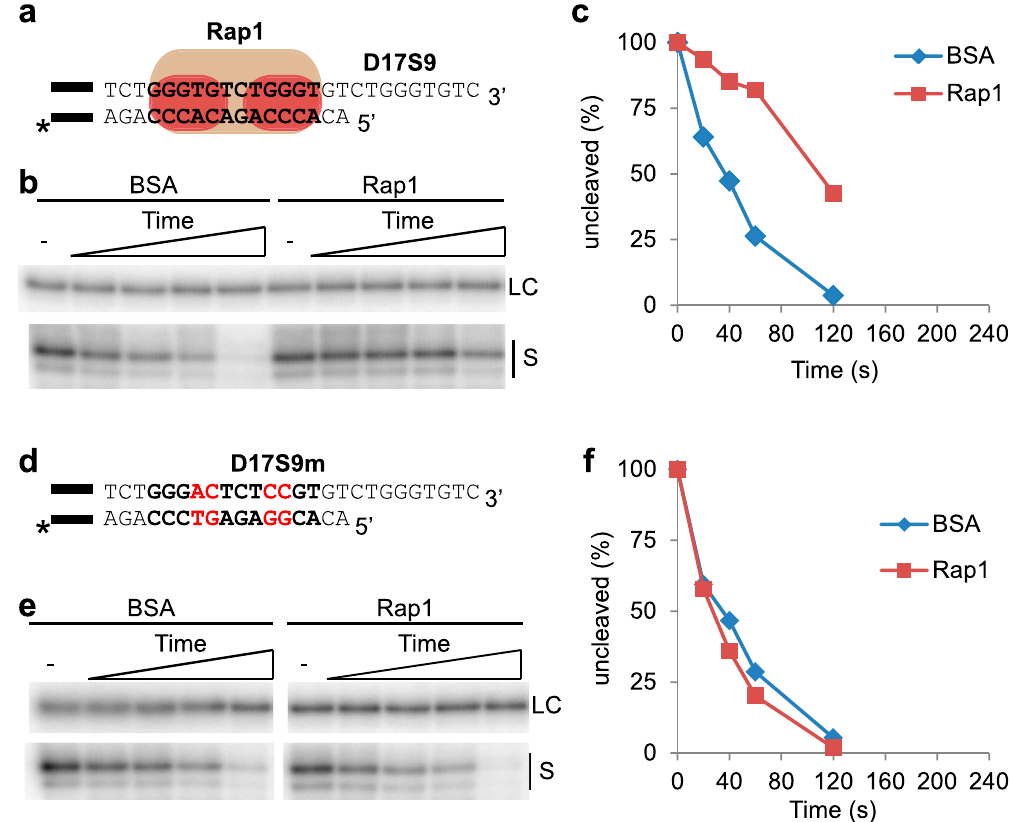
Figure 4. Rap1 protects the 5 ′ end when bound to dsDNA 2 nt inwards of the ds-ss junction. ( a,d ) The substrates used for DEPA experiments. The black bar indicates the guide sequence, and “ * ” the radioactive label (as described in Fig. 2 legend). ( a ) The telomere substrate D17S9 contains 17 bp dsDNA and a 9 nt 3 ′ overhang. The Rap1 MBS (bold text) is located 2 nt inwards of the ds-ss junction. ( d ) Substrate D17S9m contains 17 bp telomere dsDNA with four mutations in the Rap1 MBS (bold letters, mutations in red) and a 9 nt ssDNA 3 ′ overhang. ( b,e ) DEPA sequencing gels of D17S9 ( b ) and D17S9m ( e ), showing the loading control (LC) and uncleaved substrate (S) from the Rap1 containing and BSA control reactions at 0; 20; 40; 60; 120 s. Full-size gel showing all the reaction products can be found in Supplementary Fig. S4. ( c,f ) Quantification of the gels shown in ( b ) and ( e )